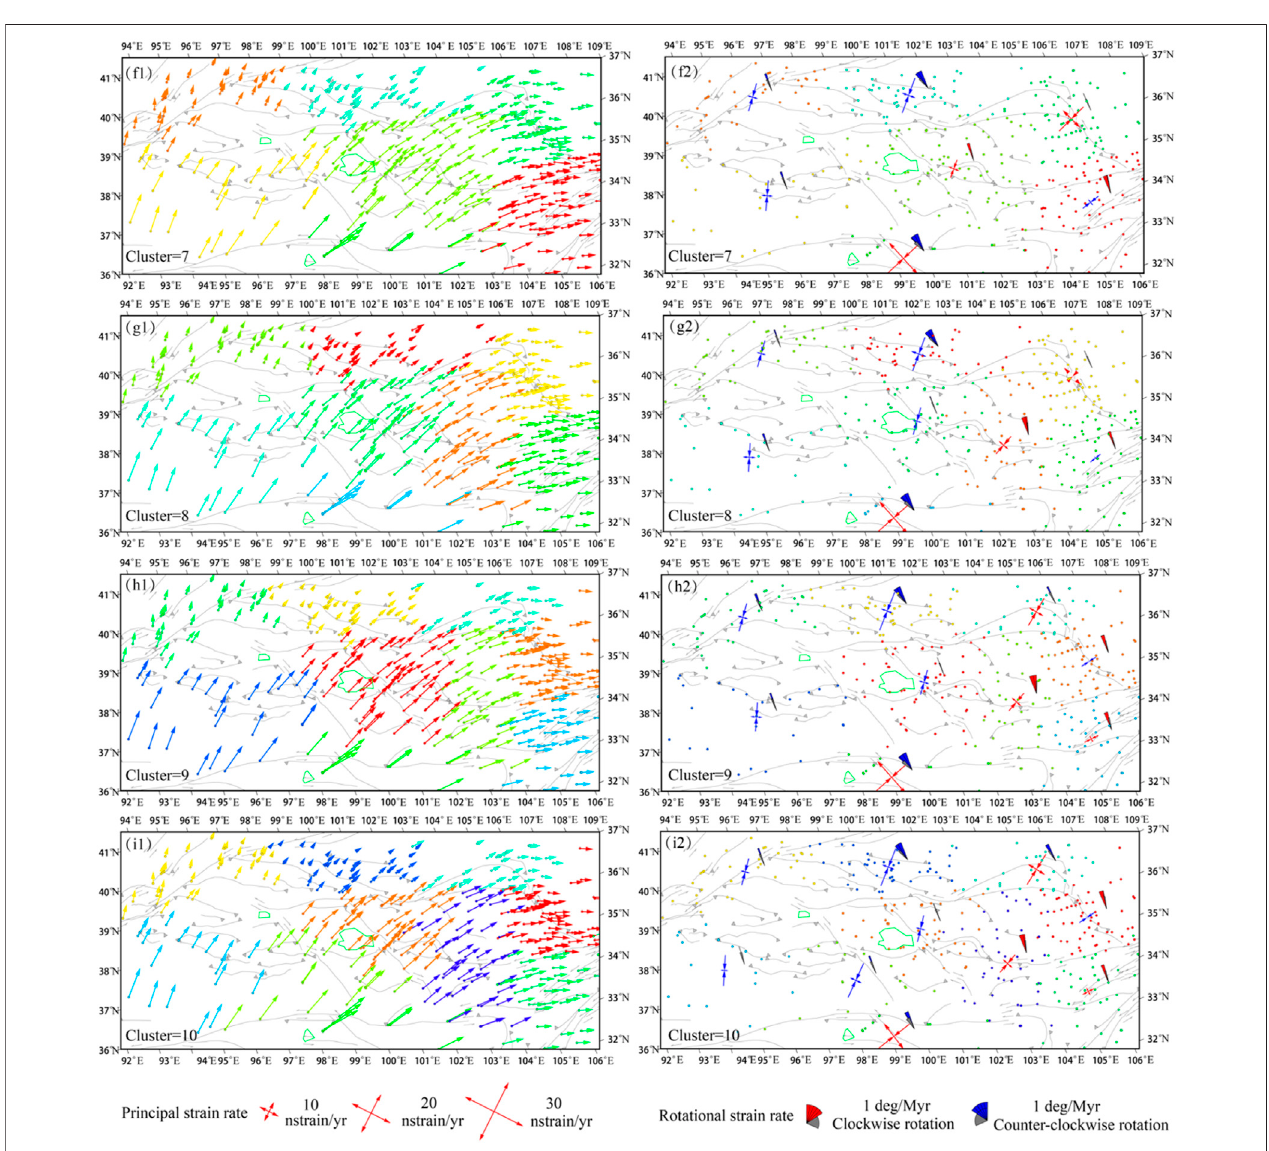
FIGURE 6 | Clustering velocity result for K = 7 – 10 and their calculated principal strain rate and rotational strain rate. f1 – i1 represent the velocity result of cluster analysis, and f2 – i2 represent the strain rate for each cluster.